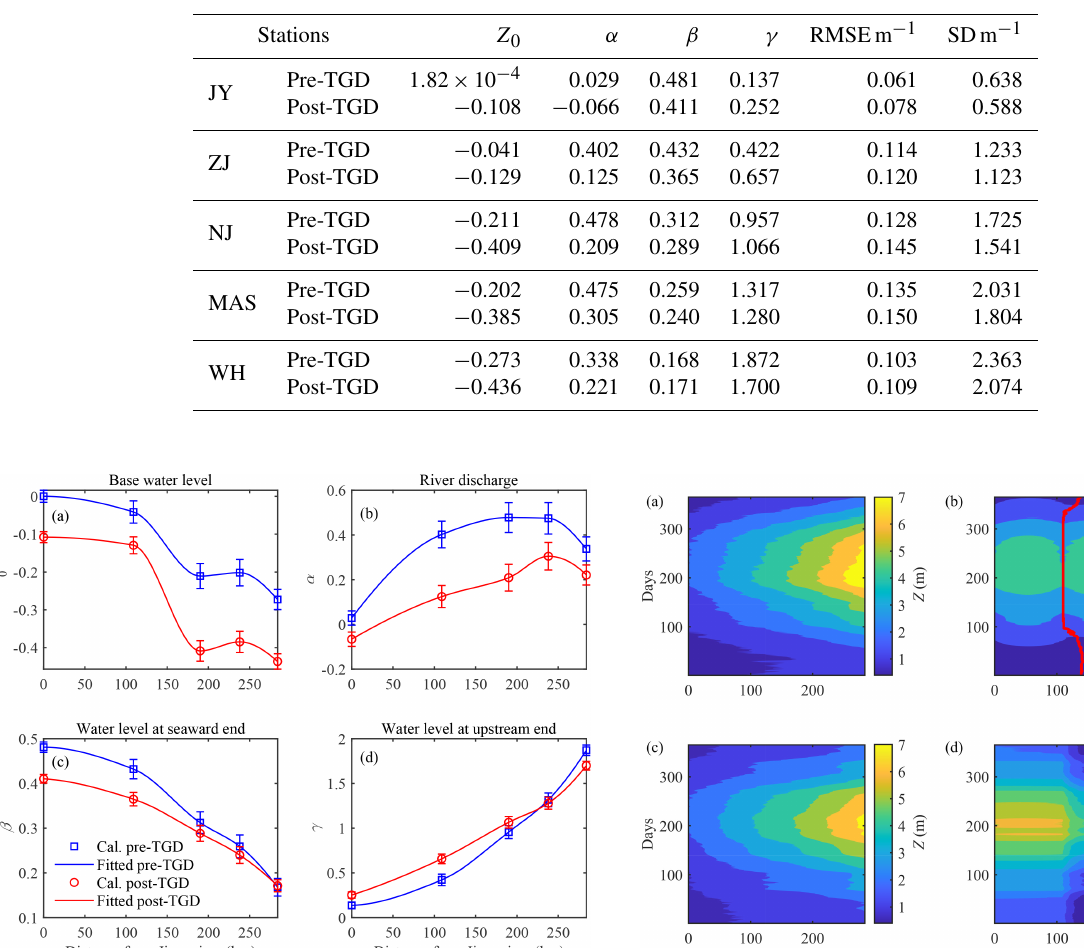
Table 1. Calibrated linear regression coefficients for both the pre-TGD and post-TGD periods along the upper YRE.